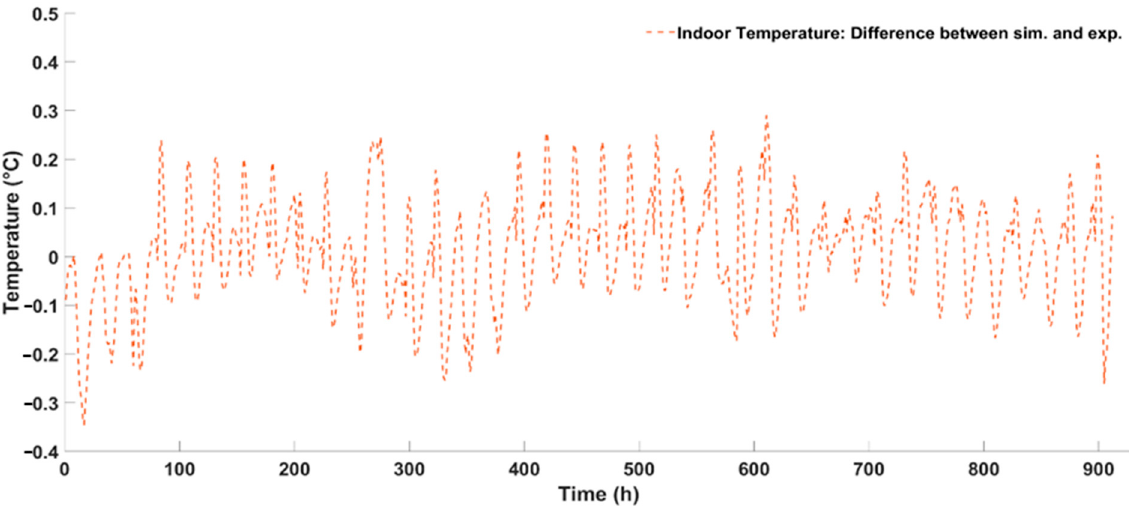
Figure 21. Deviation between the simulation and experimental results of indoor temperature.